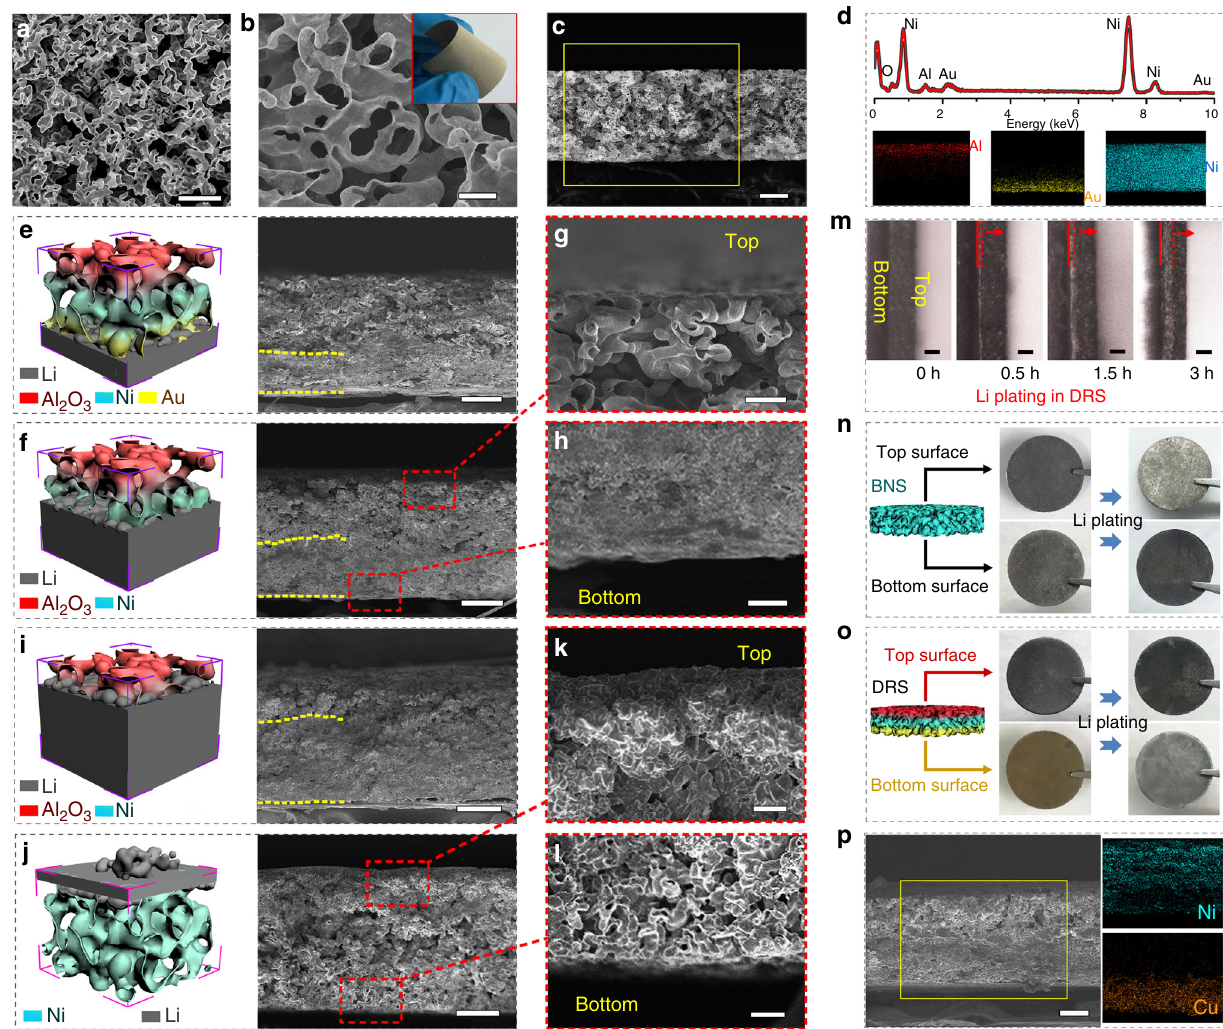
Fig. 2 SEM and optical microscopy characterization of BNS and DRS. SEM images of the top surface of a BNS and b DRS, and of c the cross section of the DRS. d EDS plot and elemental mapping of Al, Au, and Ni in the cross section of the DRS. e − l Schematic illustration and cross-sectional SEM images of the Li-plating process: Bottom – up plating in the DRS with capacities of e 3, f − h 5, and i 8 mAh cm − 2 , respectively (the yellow dash lines indicates the edges of Li-deposited regions). j − l Surface plating in a BNS with a capacity of approximately 3 mAh cm − 2 . m Optical microscopy images of the cross section of the DRS, which show the Li-plating process over time (the red arrow indicates the direction of Li growth). Photographs of n BNS and o DRS, respectively, before and after Li plating. p SEM and EDS elemental mapping images of a Li-plated DRS, which was treated with CuCl 2 solution in dimethoxyethane. Scale bars: ( a , c , e , f , i , j , p ), 25 μ m; ( b , g , h , k , l ), 5 μ